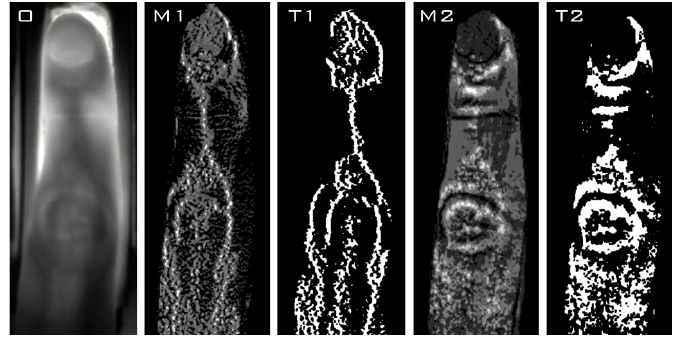
Figure 2. Exemplary results of processing images with MDT (before and after binarization) using two sizes of operational window (9 × 3 pixels on the left and 9 × 19 pixels on the right side). O —original image, M1/M2 —image processed with MDT, T1/T2 —thresholded image (after Otsu binarization).